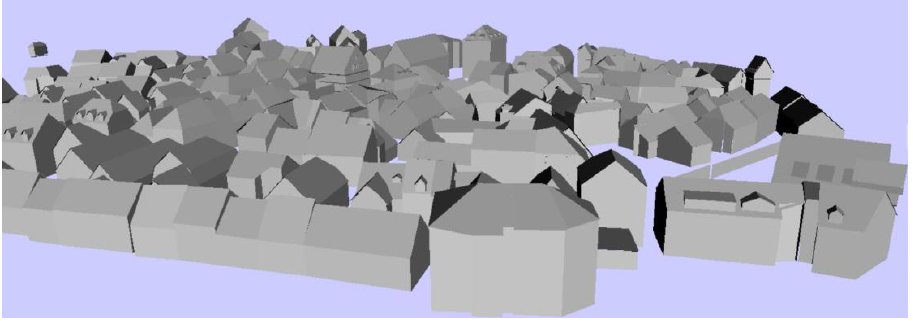
Figure 11. Exterior shell representation of a 3D city model (LOD3ES).